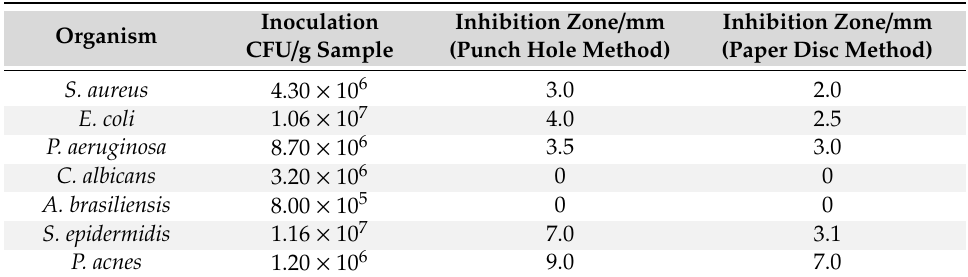
Table 5. Quantification of the inhibition zone formed, depending on the microorganism and its inoculation density for the punch hole method and paper disc method.